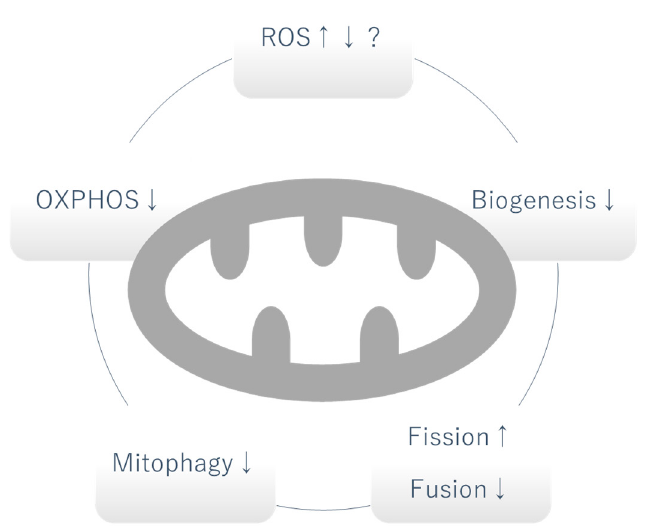
Figure 1. Mitochondrial dysfunction in DKD. Whether the level of mitochondrial ROS is increased or decreased is controversial and can vary depending on the stage of DKD. OXPHOS, mitophagy and biogenesis are generally decreased. Increased fission and decreased fusion causes fragmentation of mitochondria. OXPHOS: oxidative phosphorylation, ROS: reactive oxygen species, ↑: increased, ↓: decreased.